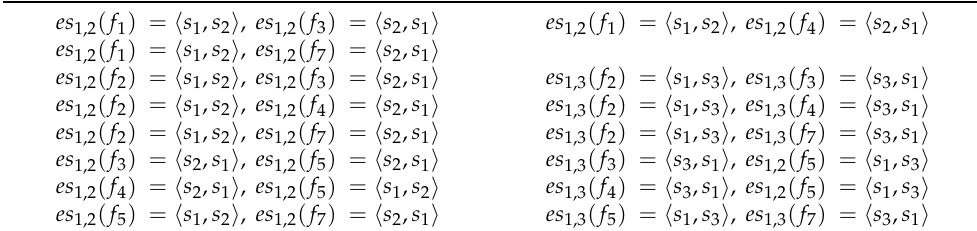
Table 6 lists the pairs of elementary sequences that distinguish faults. Table 6. List of pairs of elementary sequences distinguishing faults.